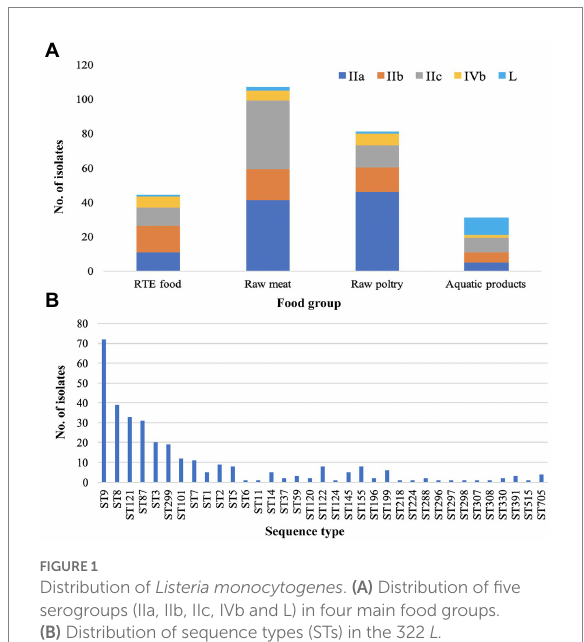
FIGURE 1 Distribution of Listeria monocytogenes . (A) Distribution of five serogroups (IIa, IIb, IIc, IVb and L) in four main food groups. (B) Distribution of sequence types (STs) in the 322 L. monocytogenes